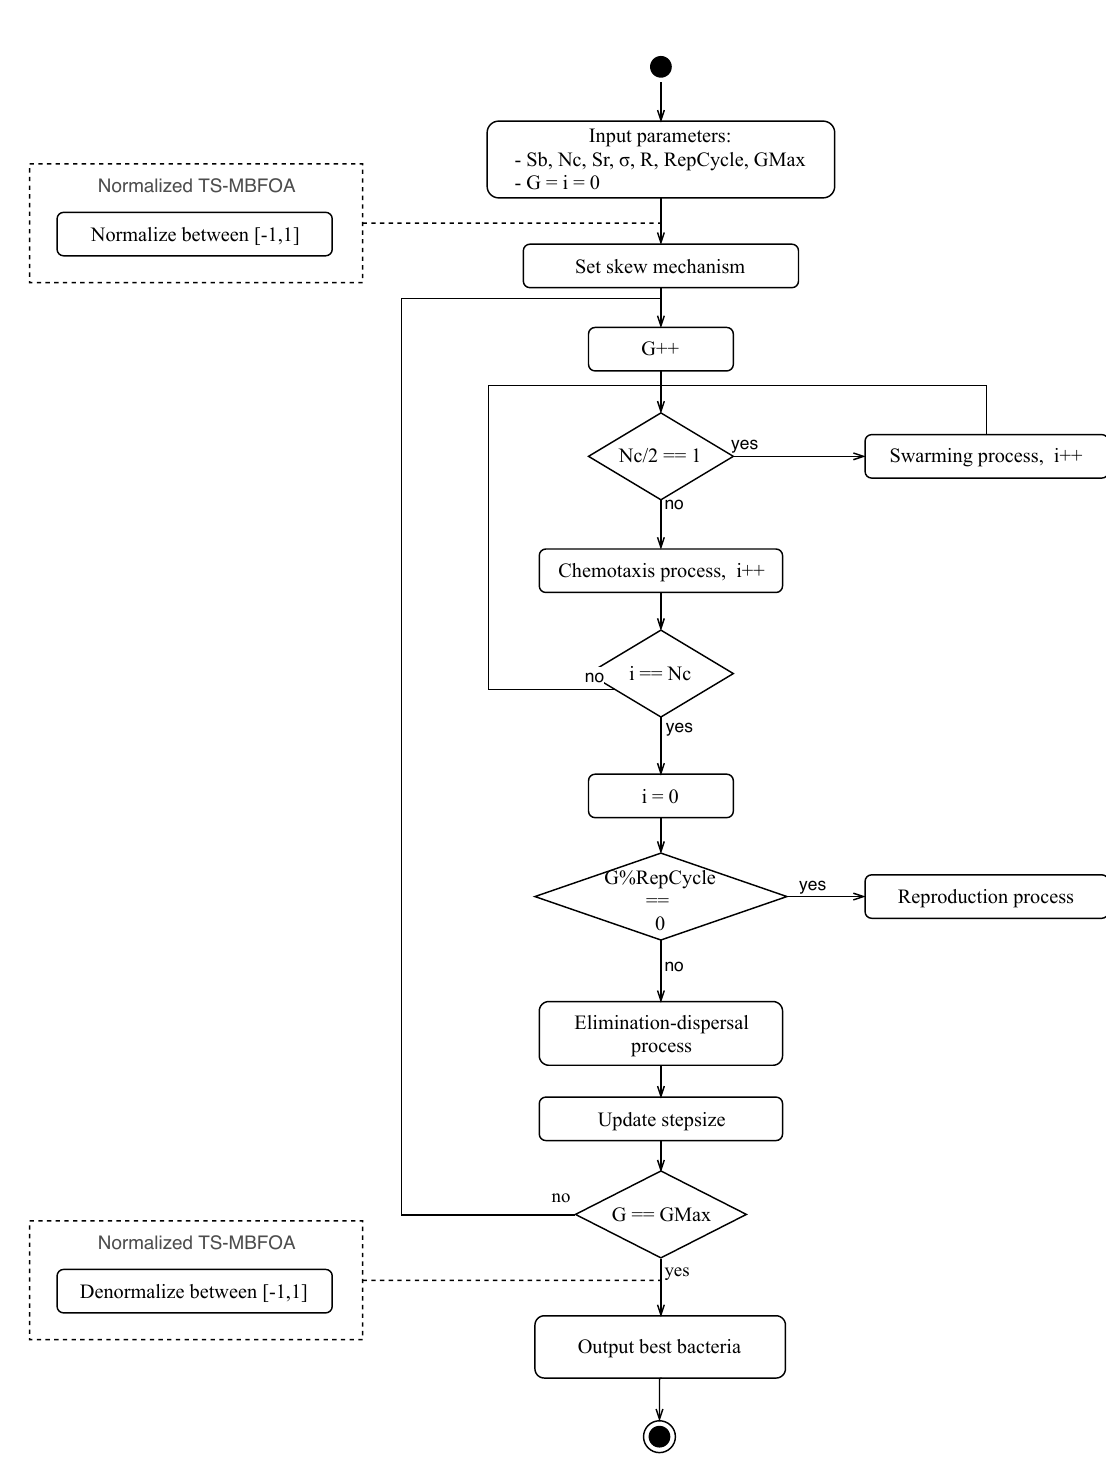
Figure 3. [Normalized] Two-Swim Modified